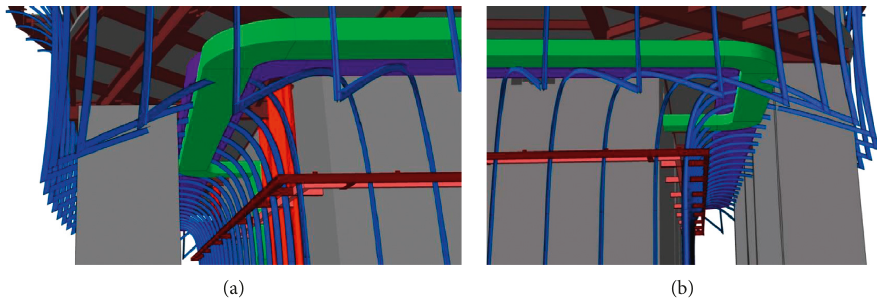
Figure 6: Clash detection between the secondary steel structure and MEP system.